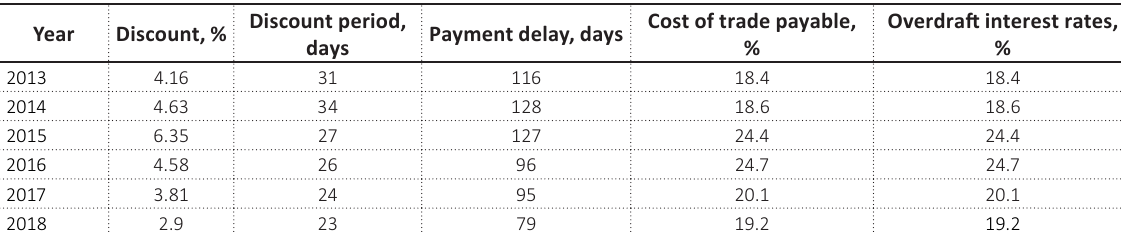
Table 6. The cost of trade credit in case of the overdraft interest rates